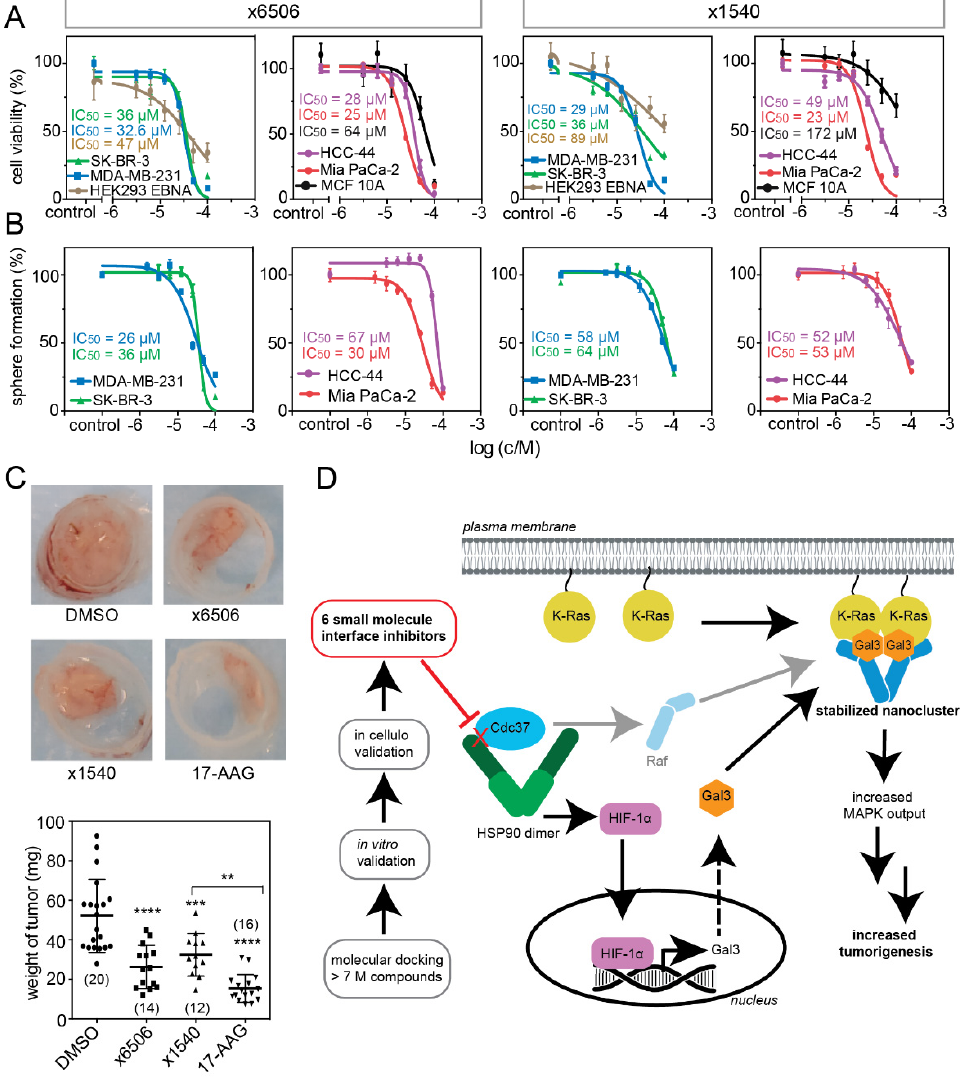
Figure 7. Top compounds inhibit 2D and 3D cancer cell growth and microtumor formation in the CAM model. ( A ) Compounds ×6506 or ×1540 dose-dependently reduced the 2D proliferation of several cancer and non-transformed cell lines after 72 h; n = 3 independent biological repeats. ( B ) Compounds ×6506 or ×1540 dose-dependently reduced the 3D spheroid growth of several cancer cell lines cultured under low attachment and serum-free conditions after 72 h; n = 3 independent biological repeats. ( C ) Microtumor formation of MDA-MB-231 cells on chick embryo CAM. The cells were treated with 0.1% DMSO vehicle control, 20 μ M ×6506 or ×1540, or 10 μ M 17-AAG for 5 days; n = 2 independent biological repeats. The number of analyzed microtumors per condition is given in brackets in the plot. ( D ) Summary scheme showing, on the left, the compound screening success, leading to six new small molecule Hsp90/Cdc37 protein interface inhibitors that could serve as a starting point for drug development. The major part on the right illustrates how Hsp90 activity is linked to the K-Ras signaling output via HIF-1 α and Gal3, which can stabilize the K-Ras nanocluster and thus increase the MAPK-output. According to our nanocluster model, Raf proteins are integral components; hence, we here indicate a potential mechanistic contribution via Raf. However, it is currently unknown which Raf-dimers preferentially stabilize the K-Ras nanocluster. ** p < 0.005, *** p < 0.001, **** p <